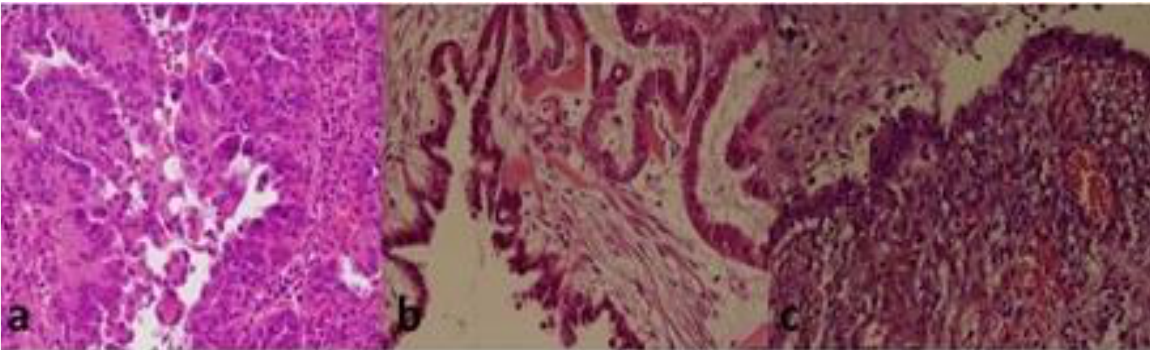
Fig 1. Photomicrograph of human ovarian tumor tissue . A) A photomicrograph of human ovarian serous cyst adenocarcinoma infected with HPV DNA. B) A photomicrograph of human ovarian serous cyst tumor borderline infected with HPV DNA. C) A photomicrograph of human ovarian endometrium benign lesion infected with HPV DNA. (H and